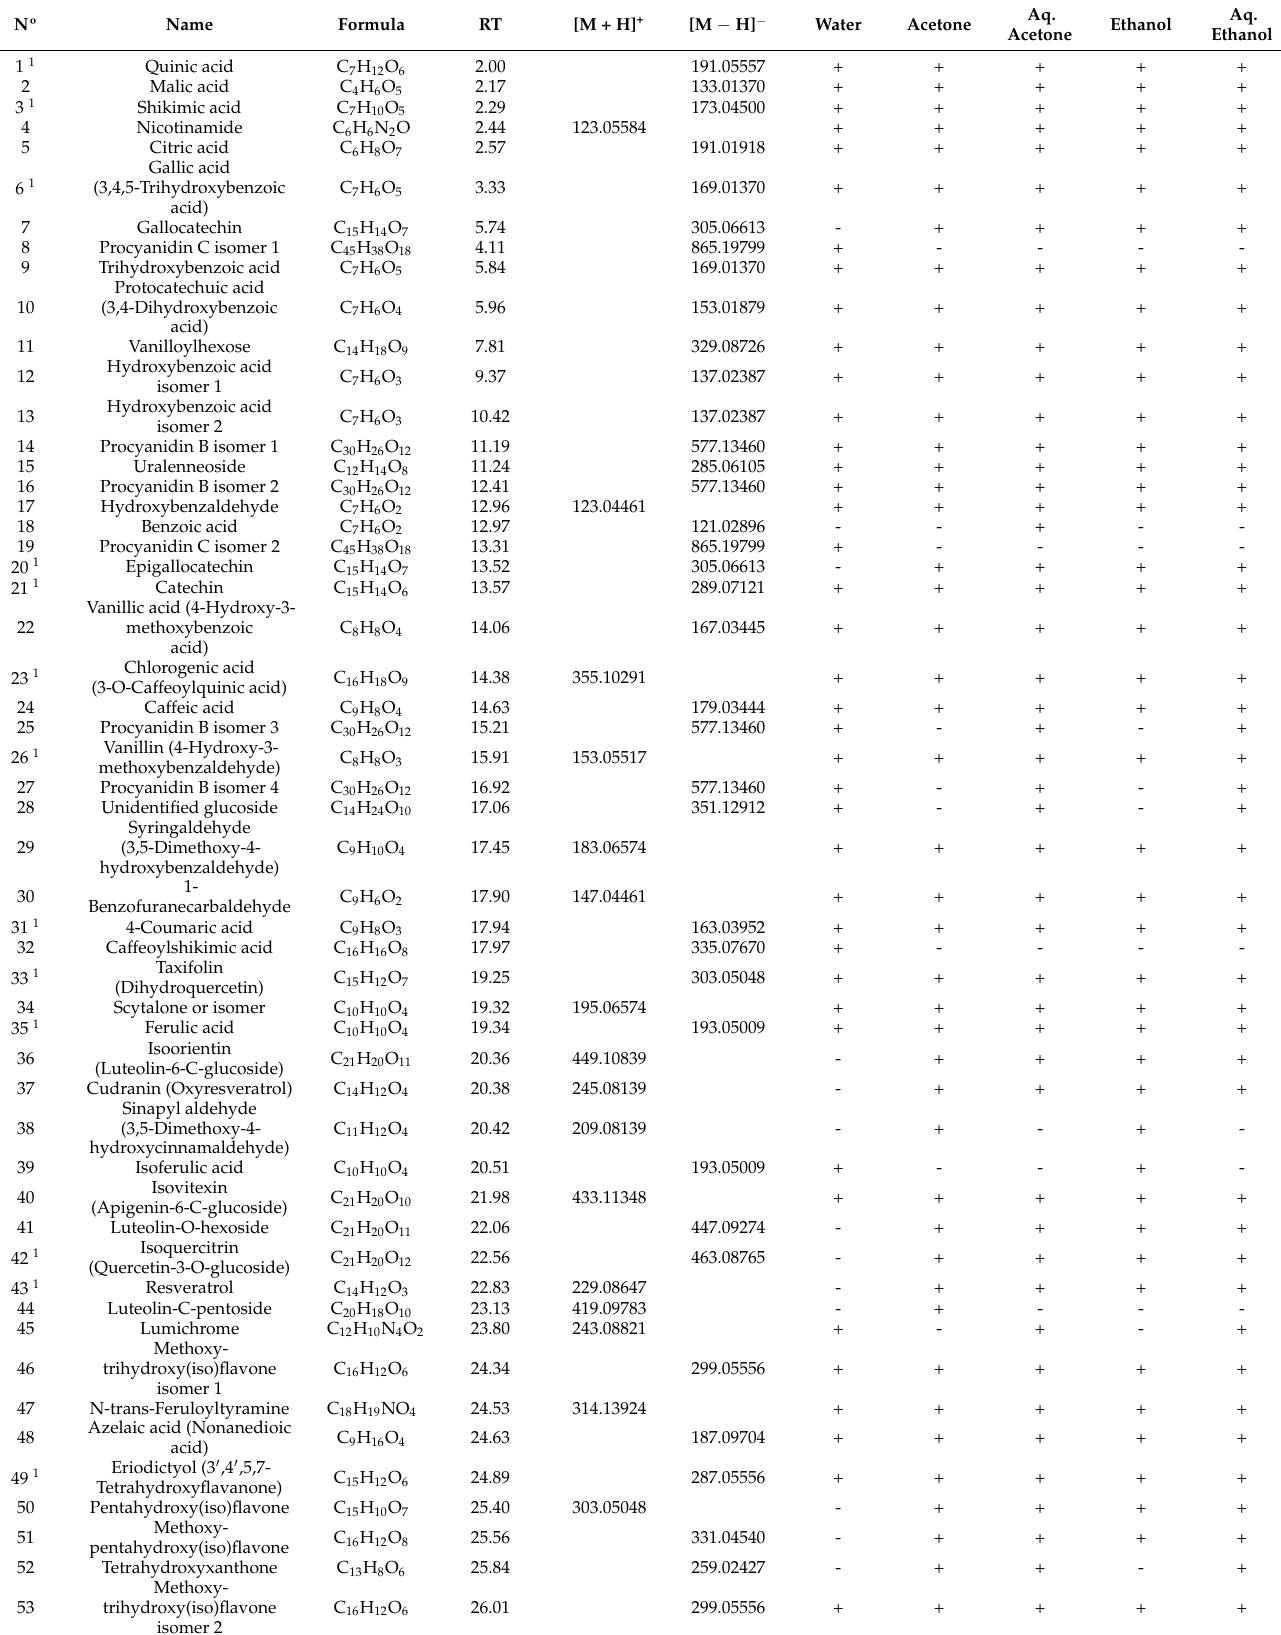
Table 2. Metabolite profiling of extracts from Cladium mariscus (sawgrass) seeds by HPLC-ESI-